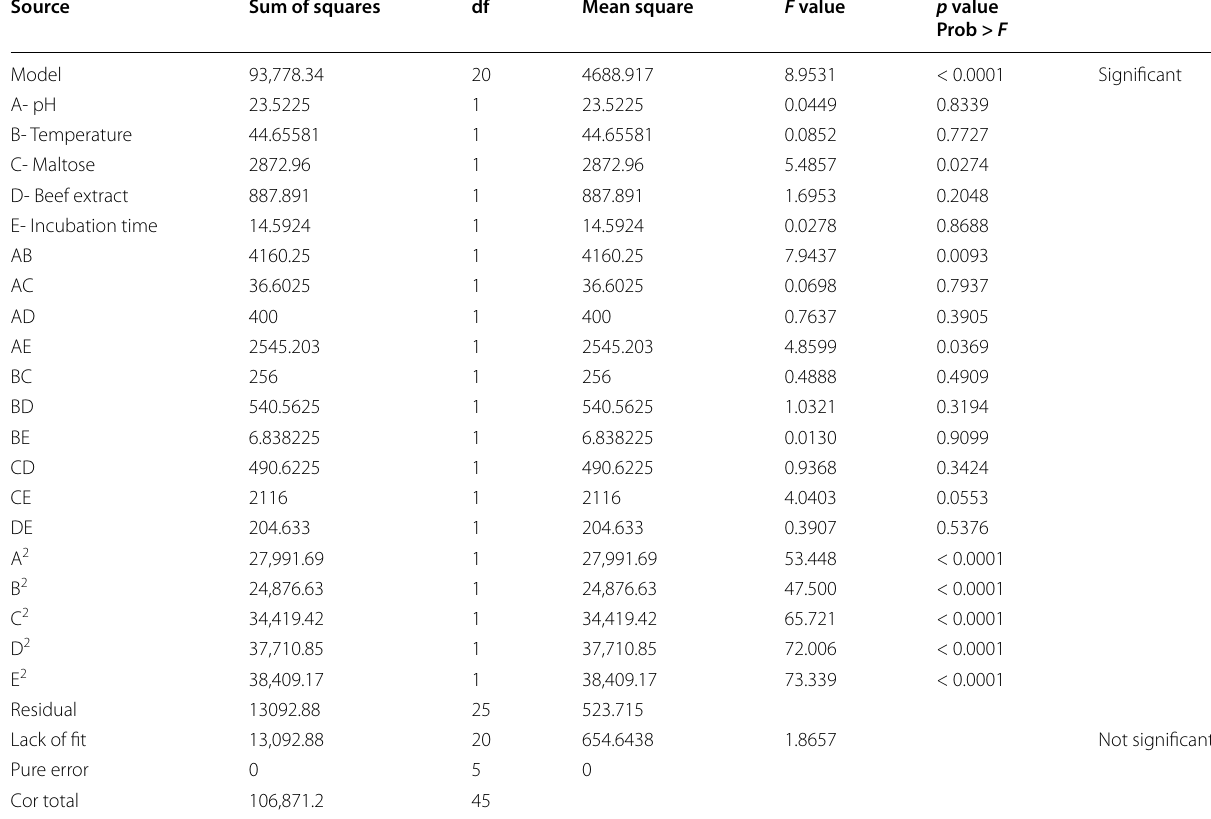
SD (22.885); mean (138.948); C.V % (16.470); PRESS (52371.504); R 2 (0.907); adjusted R 2 (0.779); predicate R 2 (0.510); Adeq precision (10.644)